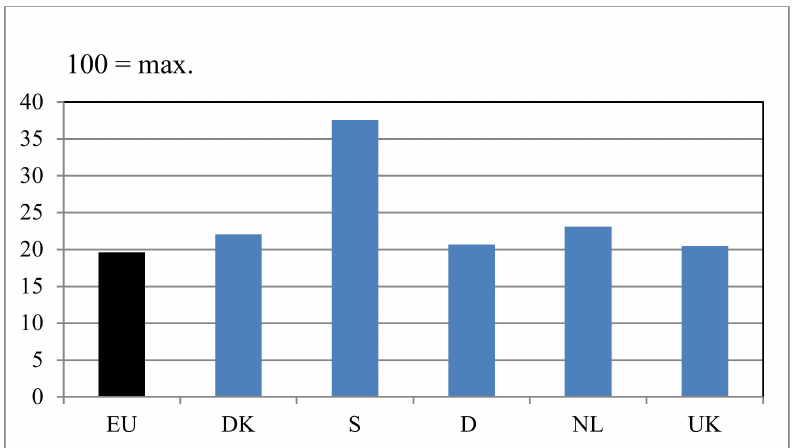
Figure 3. Comparison of Benchmark values (on a scale from 0 to 100) as they would be if all production was done in accordance with minimal requirements from the European Union (EU) (the EU column) or in accordance with national legislation (the other